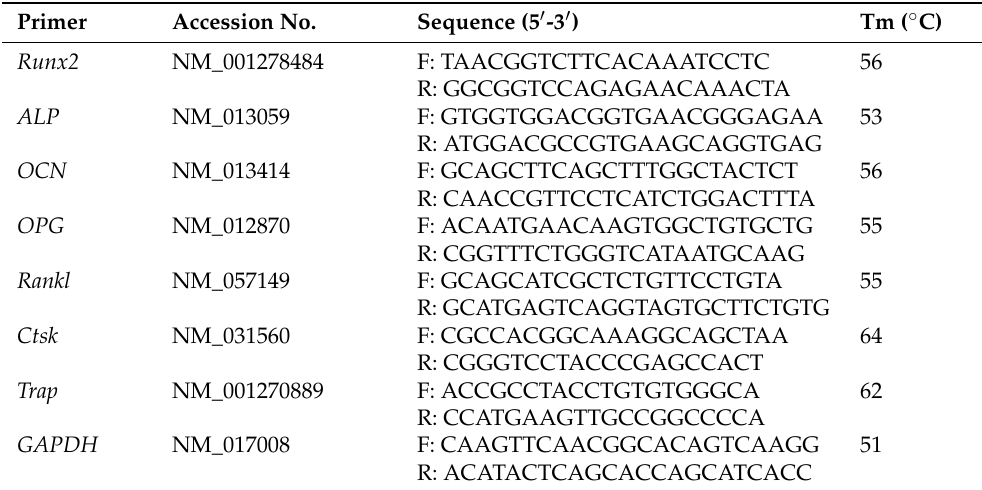
Table 1. Primers used for Real-time